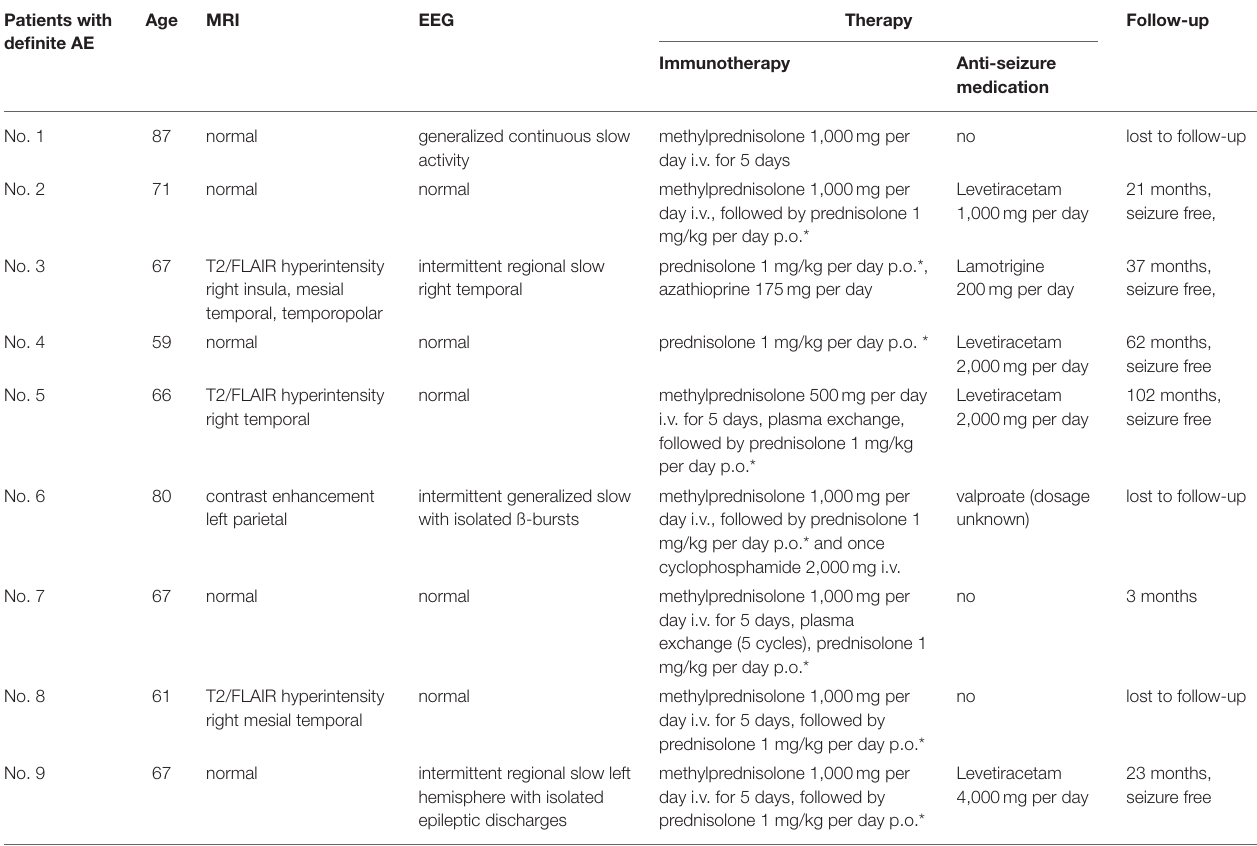
TABLE 1 | Patients with definite AE. Patients with definite